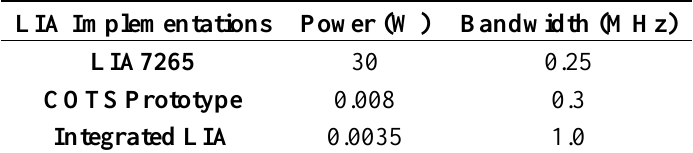
Table 6. Consumption comparison between different LIA